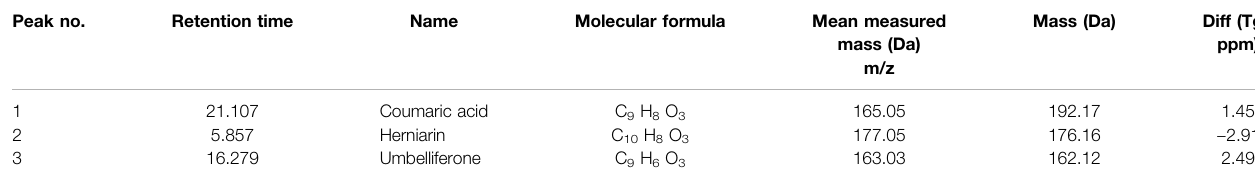
TABLE 4 | QTOF-ESI-MS data of identi fi ed plant metabolites from fraction F1 in positive mode [M+H] + with the possible molecular formula. Peak no.